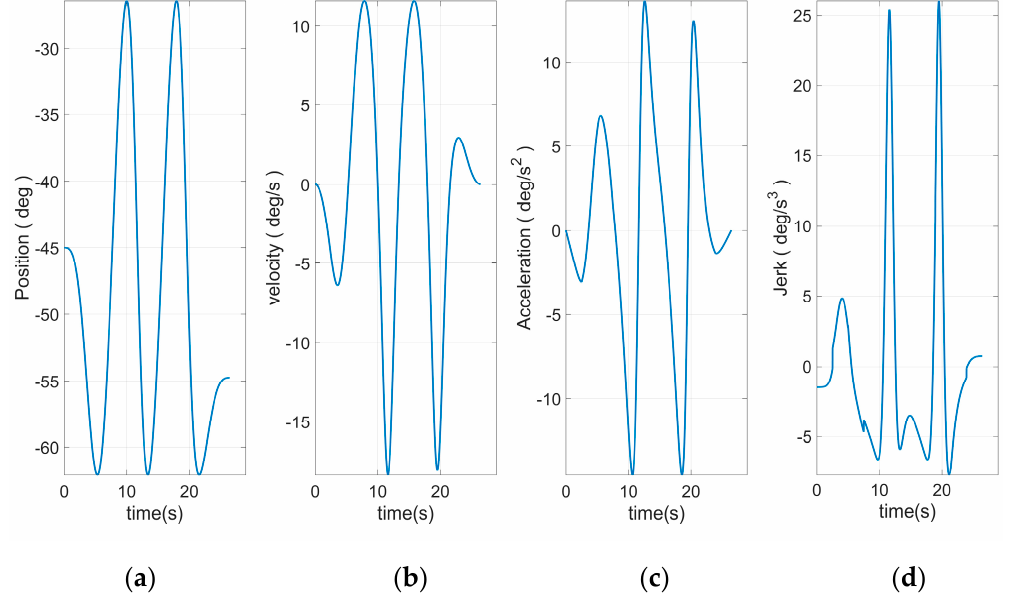
Figure 25. ( a ) Displacement of axis VI over time by using seven segments S-curve. ( b ) Velocity of axis VI over time by using seven segments S-curve. ( c ) Acceleration of axis VI over time by using seven segments S-curve. ( d ) Jerk of axis VI over time by using seven segments S-curve.